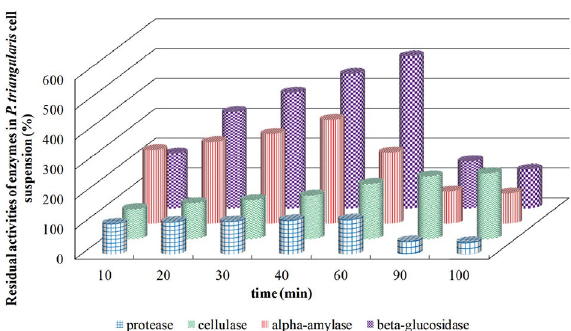
Figure 8: Residual activity of various enzymes in the P. triangularis cell suspension in relation to homogenization time at 35 °C and a homogenization speed of 25,000 rpm. Experiments were repeated three times. Standard deviation for all measurements was less than ± 3%.